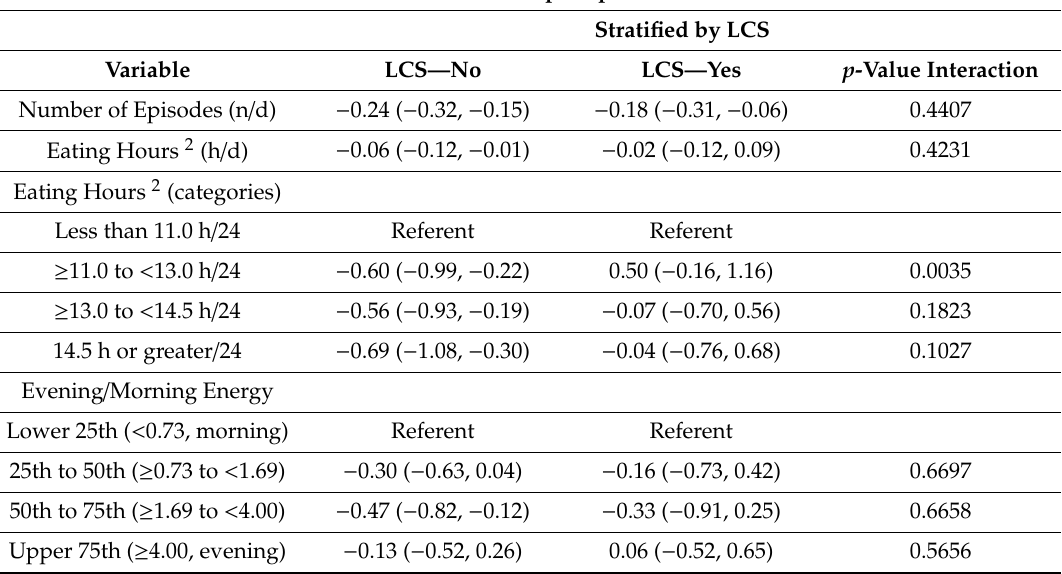
Table 4. Estimated mean BMI di ff erences per indicated unit of each variable in consumers and non-consumers of LCS (NHANES 2007–2016). 1